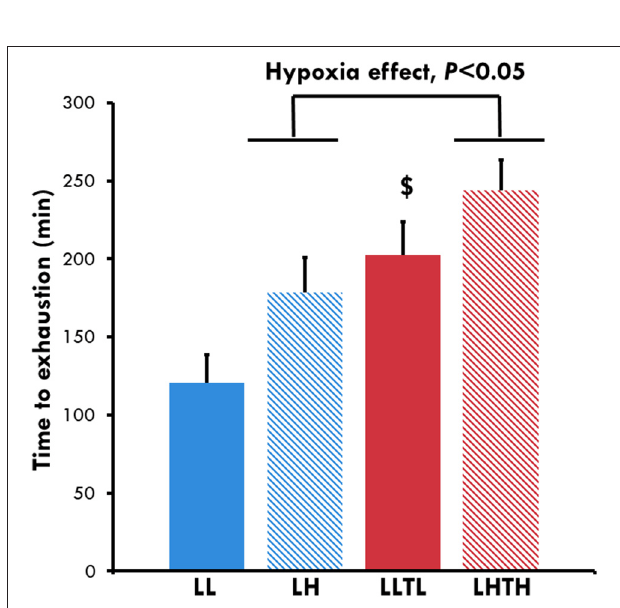
FIGURE 2 | Time to exhaustion at the end of conditioning. $ Different from the sedentary group in the same environment, P <